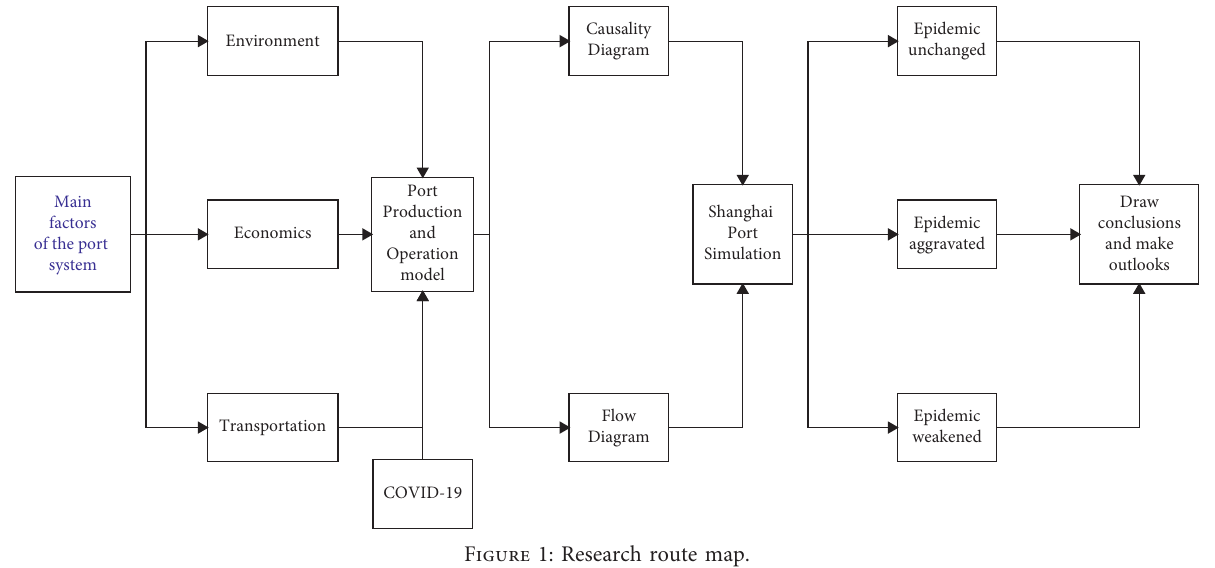
Figure 1: Research route